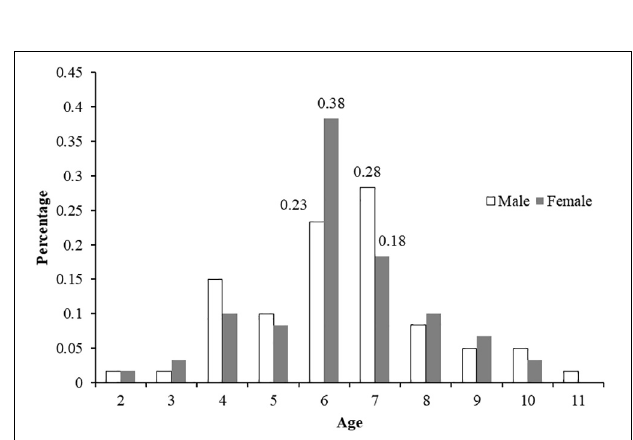
FIGURE 6 | Age-frequency distributions (n = 114) for P. kamoharai caught in the Tropical Eastern Atlantic Ocean.